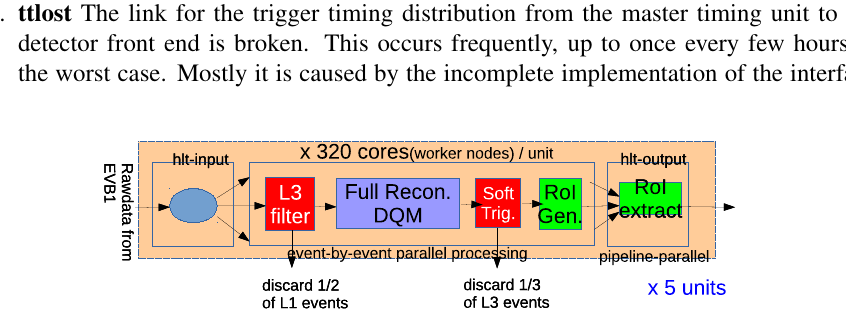
Figure 7. The HLT event processing software chain. The event data are first fed into the Level3 filter for noise reduction. The full event reconstruction follows and the software trigger decision is made. The RoIs for PXD data reduction are calculated using the processing